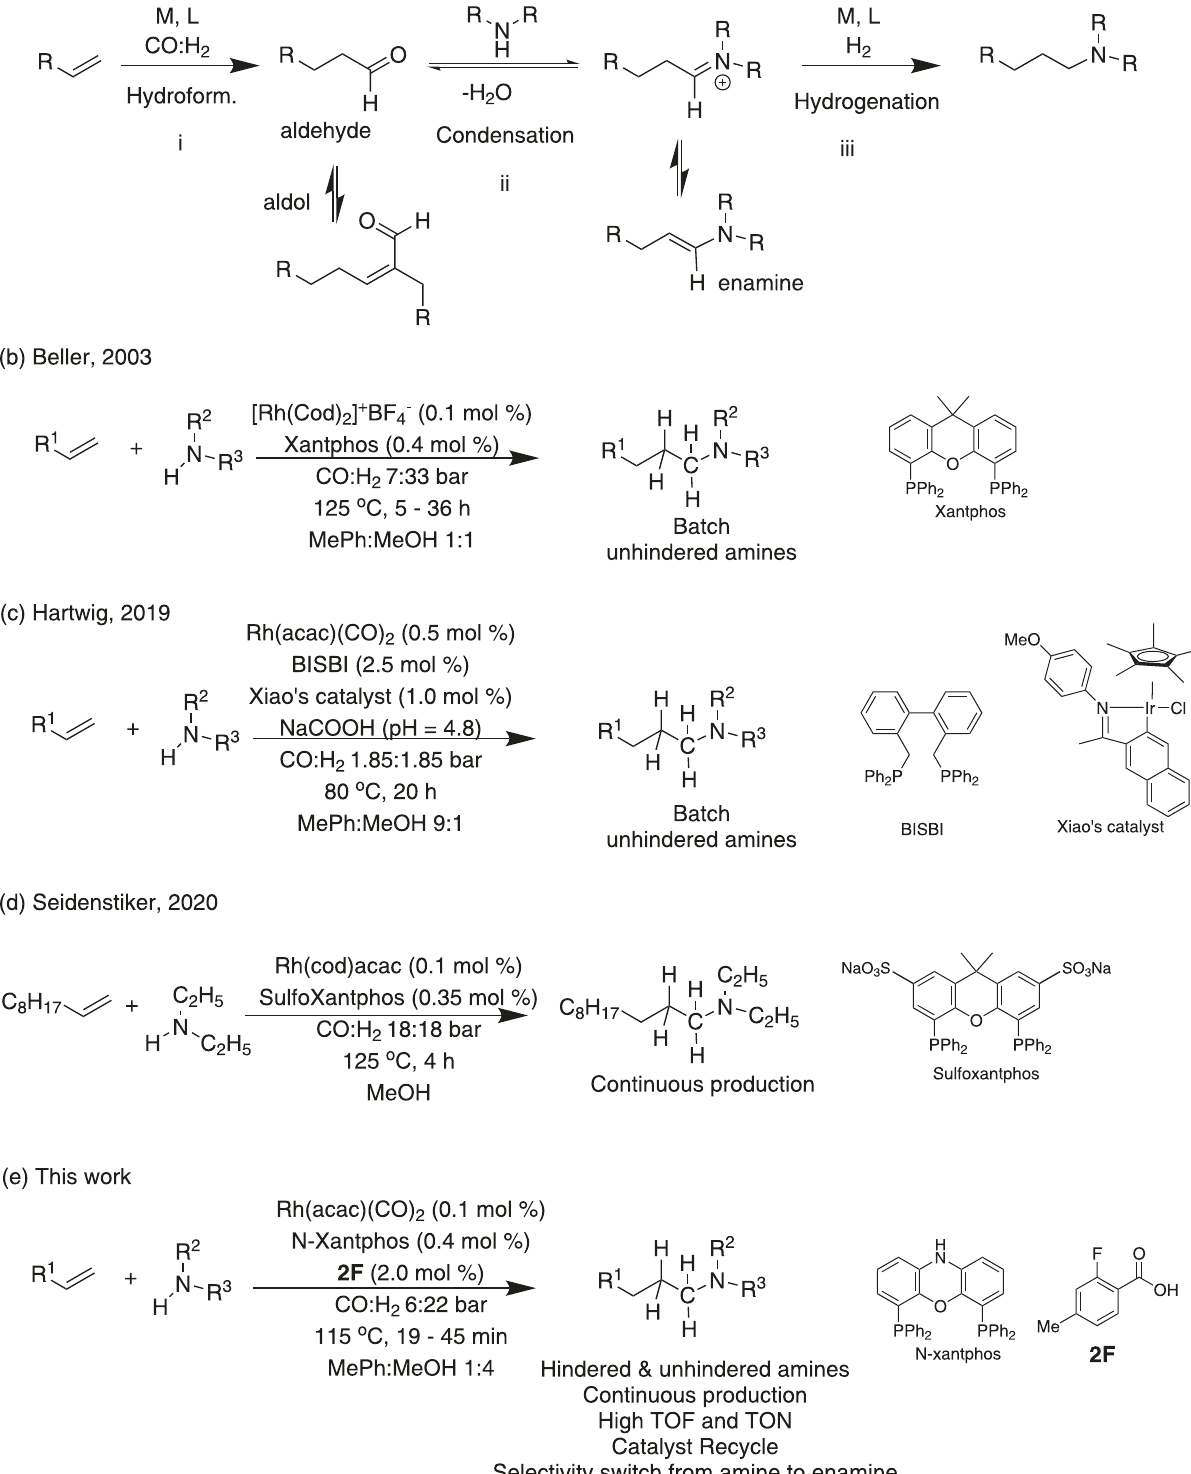
NATURE COMMUNICATIONS| (2022) 13:2441 |https://doi.org/10.1038/s41467-022-30175-0|www.nature.com/naturecommunications